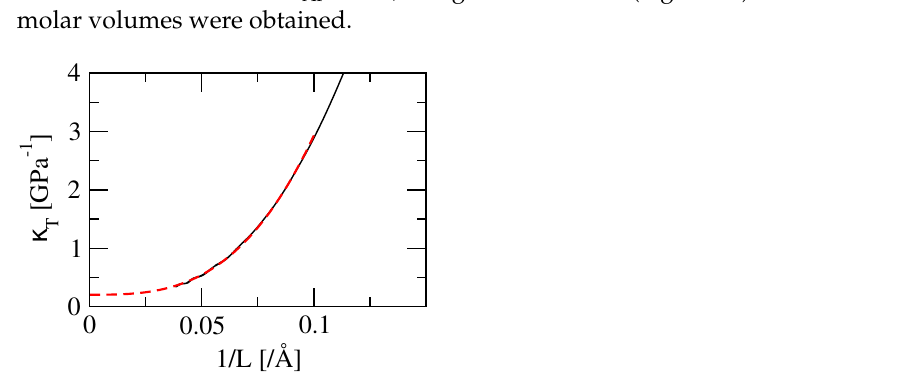
Figure 12. Isothermal compressibility (black) from KBIs at T = 85 K and x Ar = 0.02 as a function of L and cubic fit (red).